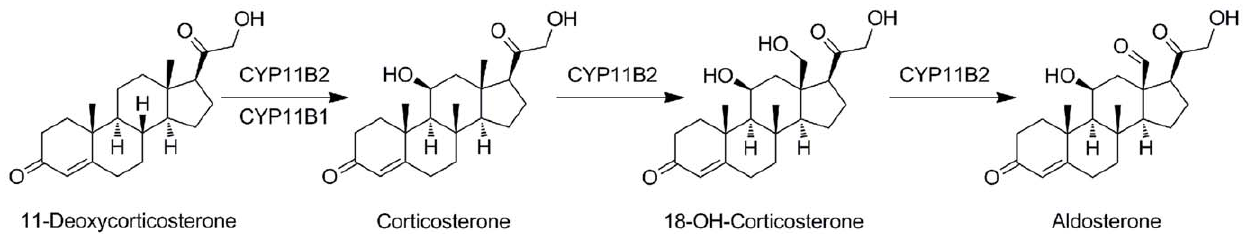
Figure 2. Biological synthesis of aldosterone catalyzed by CYP11B2.